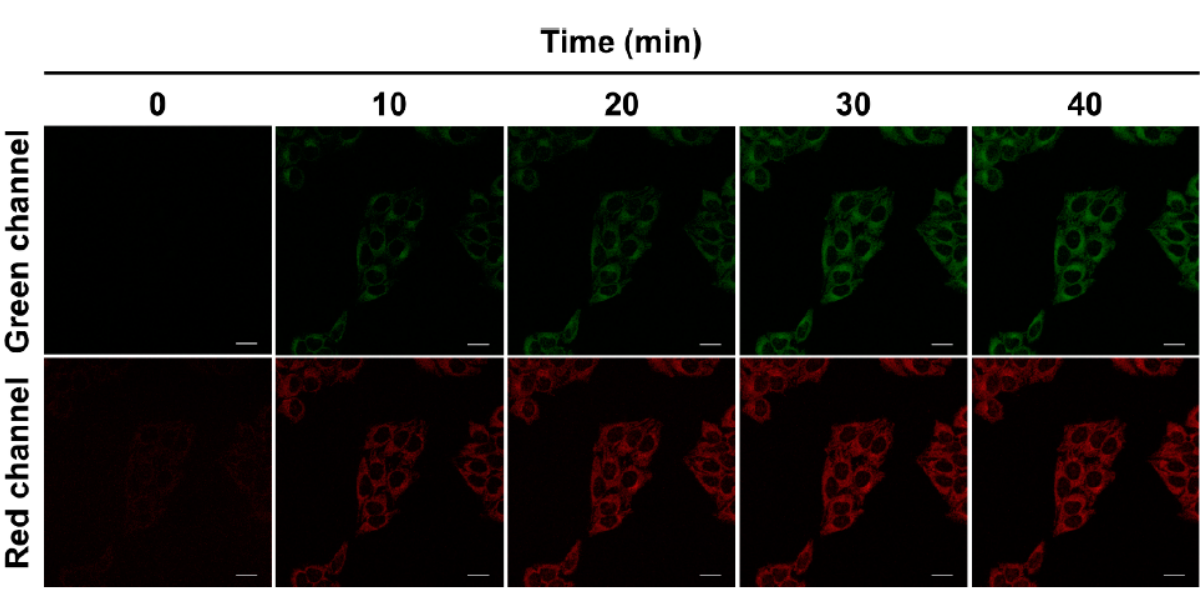
Figure 5. Cellular uptake of probe 1 over time. HeLa cells were incubated with probe 1 (15 µ M) for 0–40 min. Images were obtained with confocal microscopy adopting an excitation laser at 488 nm with band-pass filters for green (493–550 nm) and red (615–800 nm) channels. Scale bar: 20 µ m.